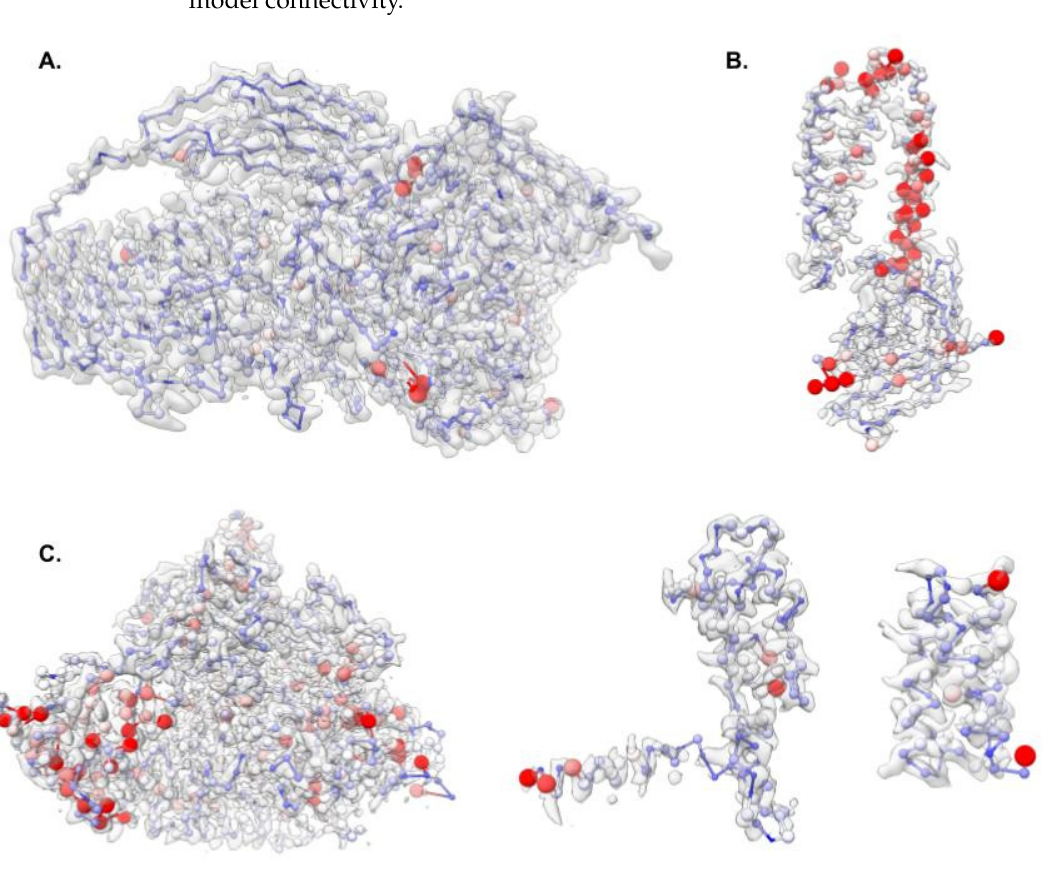
Figure 3. Probabilistic models for the 2021 CryoEM Ligand Challenge datasets. Probabilistic models for unique individual protein subunit are shown for EMD-7770 ( A ), EMD-22898 ( B ) and EMD-30210 ( C ). In ( A ), only one of the four β -galactosidase subunits is shown. In ( C ), each panel represents one of the three protein chains (A, B and C) in the map. All models are colored based on connection probability from 100% (blue) to 75% (white) and 50% or below (red). Additionally, atom diameter reflects the reliability of connectivity with larger atom diameters having less confidence.